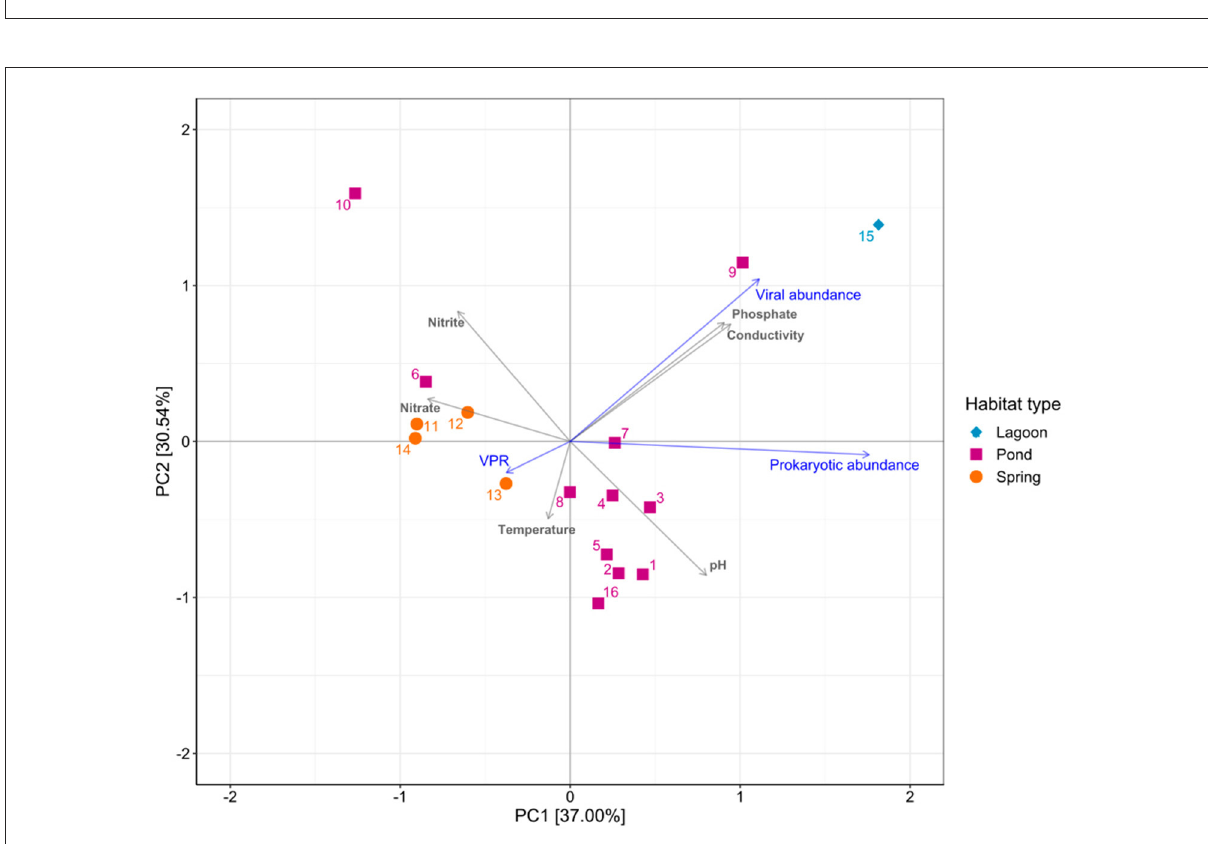
FIGURE5 Principal component analysis showing the variability of environmental variables and VPR values associated with the different habitats studied in Salar de Huasco (data from this study, Molina et al., 2018; Eissler et al., 2019,